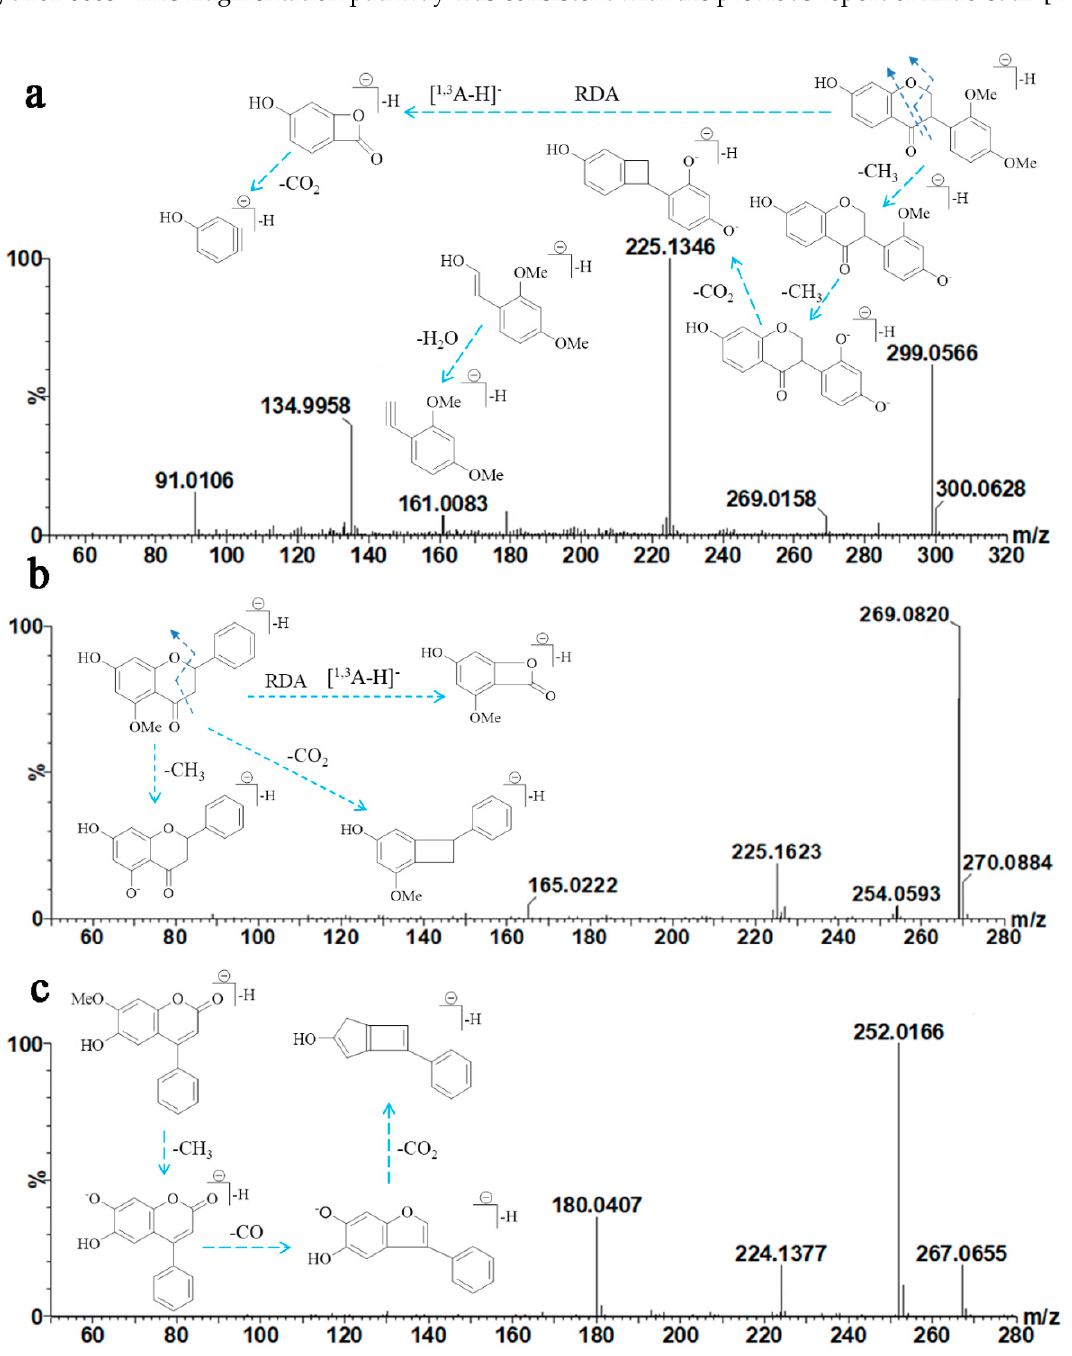
Figure 5. MS / MS spectra and the proposed fragmentation pathway of sativanone ( a ), alpinetin ( b ), and dalbergin ( c ).